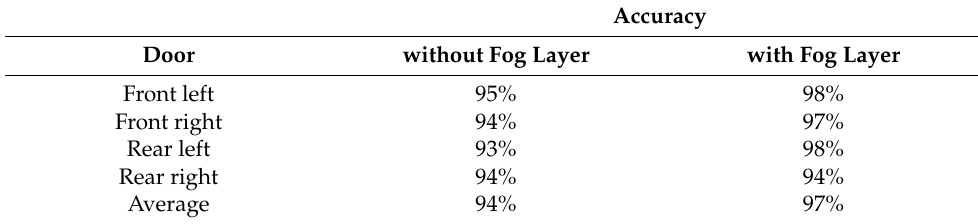
Table 5. The accuracy of the passenger counting